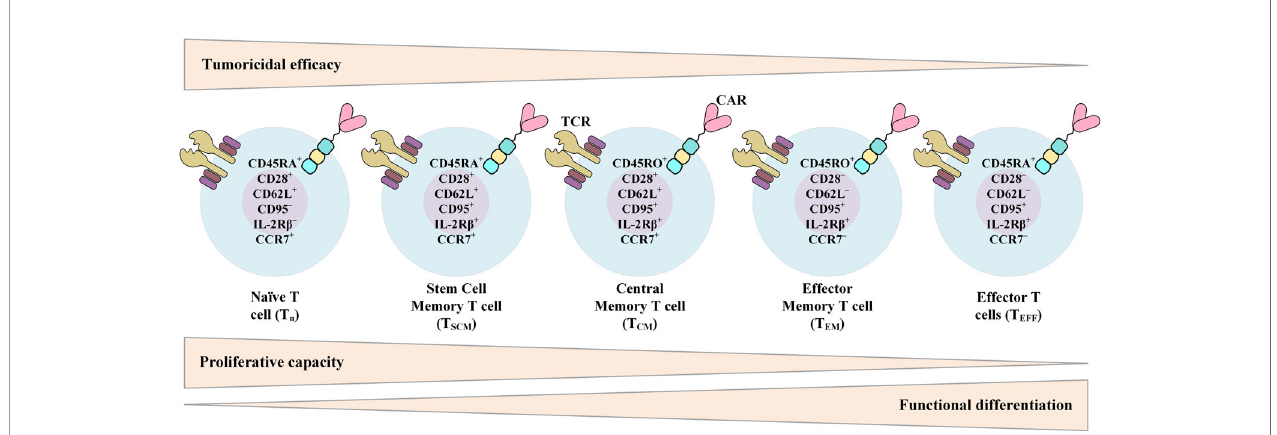
FIGURE 4 | Phenotypic characteristics of different T-cell (or CAR-T) subsets over the course of T-cell differentiation from naïve T cells to effector T cells (T EFF ) and their relationship with the proliferative capacity, functional differentiation, and tumoricidal ef fi cacy of T cells. CAR, chimeric antigen receptor; TCR, T-cell